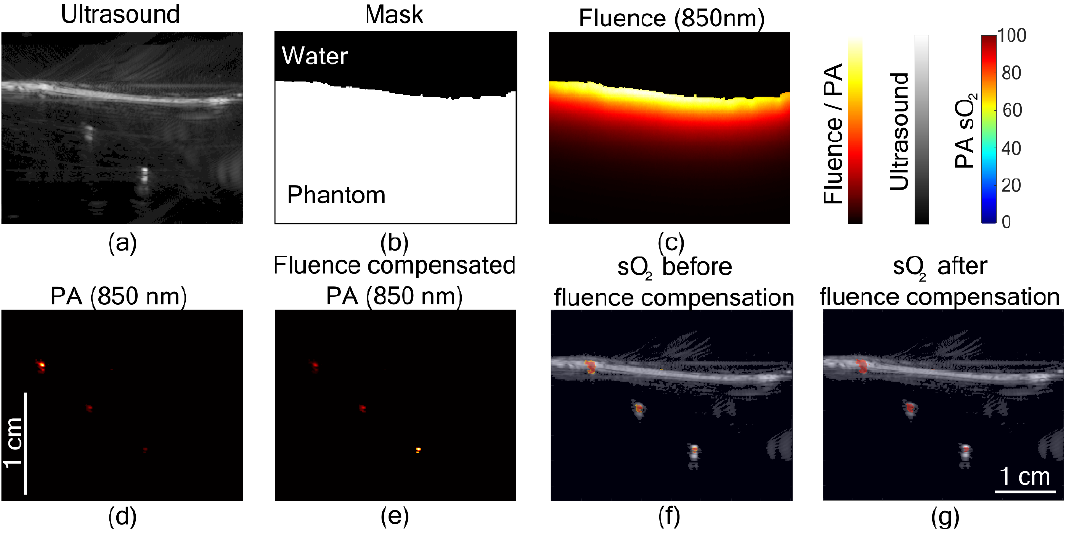
Figure 4. Ultrasound-assisted fluence compensation. ( a ) Ultrasound image of the two-layer phantom. ( b ) Binary mask obtained by segmenting ultrasound image. ( c ) Fluence map at 850 nm. ( d ) Photoacoustic (PA) images before fluence compensation at 850 nm and corresponding ( e ) fluence compensated image. Photoacoustic oxygen saturation (PA sO 2 ) images ( f ) before fluence compensation and ( g ) after fluence compensation overlaid on the ultrasound image.